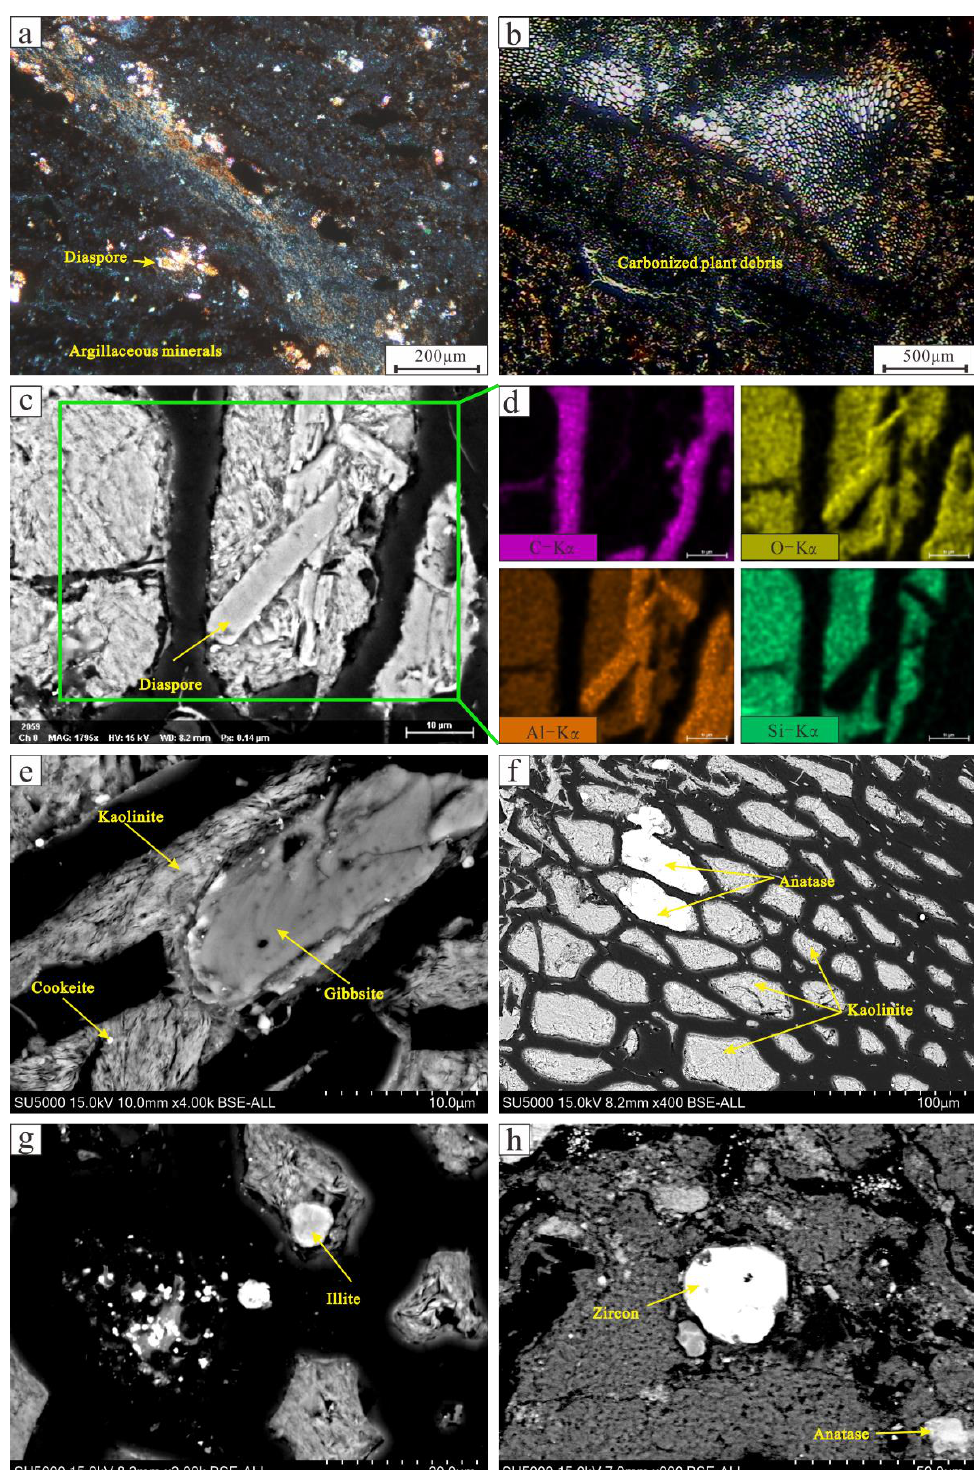
Figure 3. Optical microscope and SEM back-scattered electron images of representative samples. ( a ) Coexistence of diaspore and argillaceous minerals; ( b ) Different types of minerals filled in cell cavities of plant debris; ( c ) Elemental maps of C, O, Al, and Si obtained by SEM-based EDS microanalysis; ( d ) Enlargement of marked area in ( c ); ( e ) Kaolinite coexisting with gibbsite, and cookeite disseminated in kaolinite in granular form; ( f ) Cell cavities largely filled with anatase and kaolinite; ( g ) Illite in granular form; ( h ) Coexistence of well psephicity zircon. EDS data are as in the Supplementary Table S2.